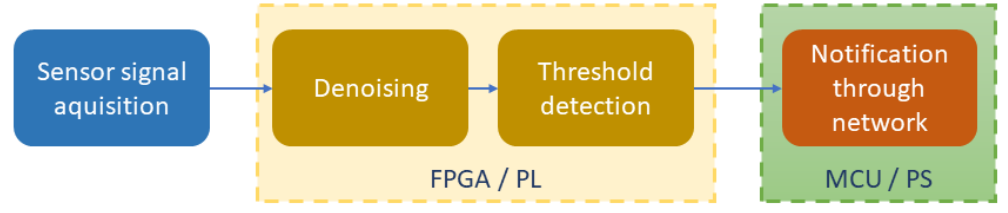
Figure 8. Data flow of the PD detection process.